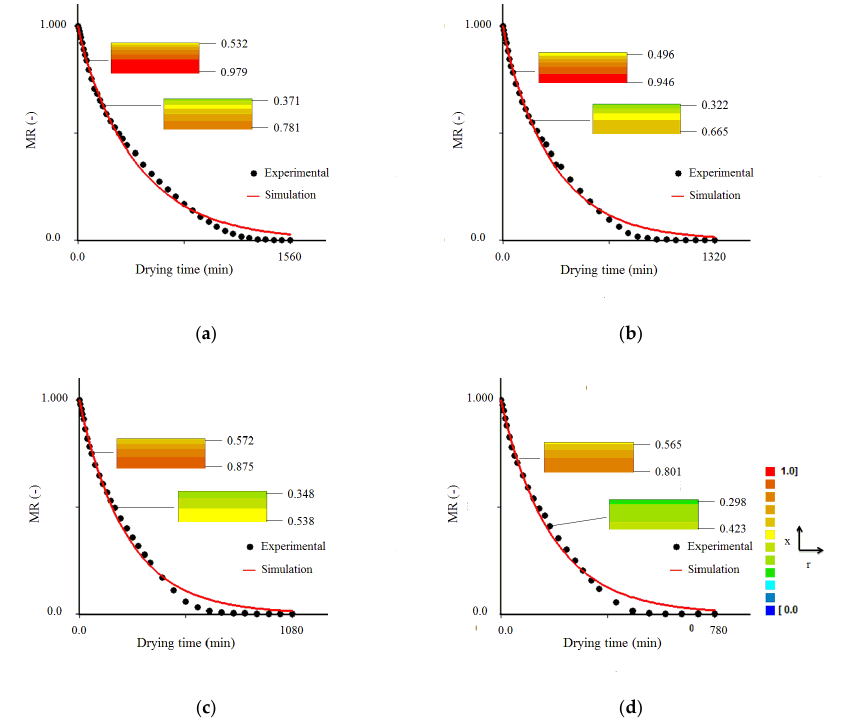
Figure 4. Cumbeba waste drying kinetics at drying temperatures of ( a ) 50 °C, ( b ) 60 °C, ( c ) 70 °C and ( d ) 80 °C, highlighting the distribution of dimensionless moisture content ( MR ) at t = 60 min and t = 180 min. Rectangles are not at scale. (For interpretation of the references to color in this figure legend, the reader is referred to the web version of this article.). In Figure 4, at t = 780 min, the mean values of dimensionless moisture content obtained by simulation were 0.16, 0.08, 0.04 and 0.02, for temperatures of 50, 60, 70 and 80 °C, respectively, reflecting the increase imposed by temperature rise on the speed of the water removal process, reducing drying time, as observed in previous studies [26,42,81]. This means that the effective mass diffusivity is lower in drying at low temperatures, as predicted by model 1 (see Table 3), which promotes the formation of a high water gradient in the sample, making the drying process less homogeneous and longer (long drying time). In addition, in Figure 4 it is possible to observe that the local moisture content has continuously decreased with the drying time. As an example, for the temperature of 50 °C, at t = 60 min, the maximum and minimum values of the dimensionless moisture content were 0.979 (base) and 0.532 (surface) and, at instant t = 180 min, these values were 0.781 (base) and 0.371 (surface) (see Figure 4a). The distributions of dimensionless moisture content for the temperature of 50 °C at six instants are shown in Figure 5, where it is possible to note that the water flow traveled from the aluminum tray-waste interface ( x = 0) to the sample surface ( x = L ) exposed to air. Over time (Figure 5a–f), the external layers of the waste become increasingly unsaturated by moisture, with progressive reduction in moisture content gradient, and it is possible to observe a drying front moving from the surface to the base of the product. Similar results have been found in previous studies, where the presence of residual moisture inside the sample was also observed experimentally and/or by